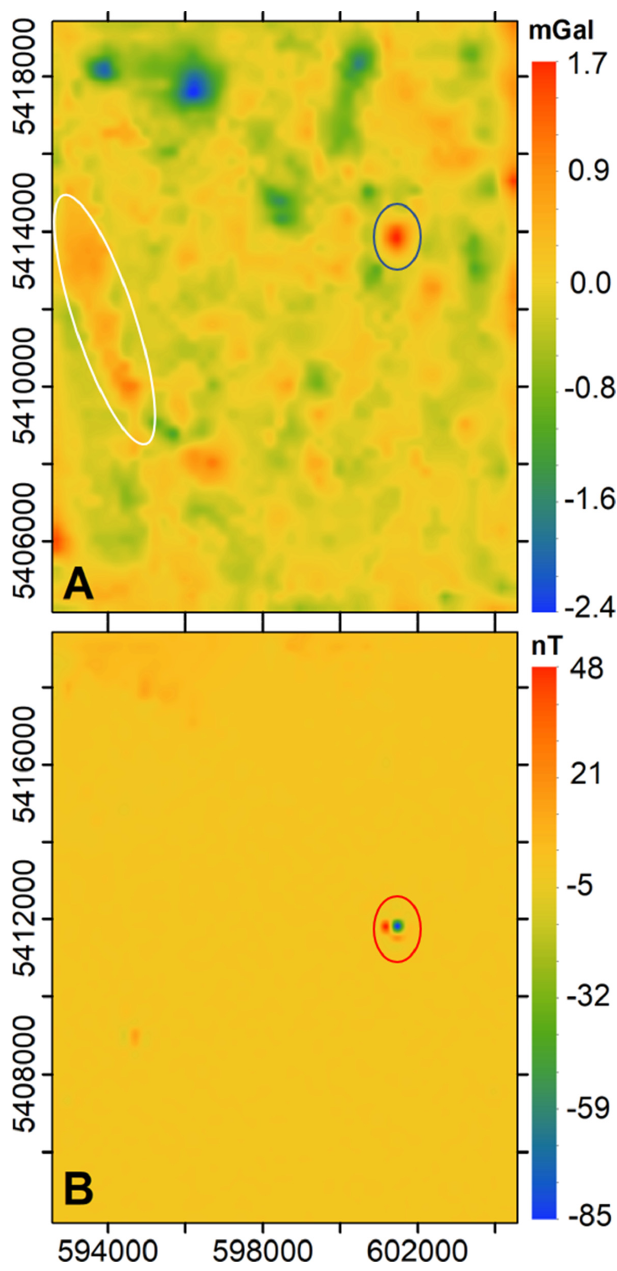
Figure 24. ( A ) The gravity residual misfit after cooperative inversion for the Scamander 3D model. The rms misfit stabilized at around 0.3 mGal, which is very low. Black and white ellipses highlight positive residuals associated with the Orieco copper prospect and Catos Creek dyke. ( B ) The TMI residual misfit with the rms misfit stabilizing at around 3 nT. The red ellipse represents outlier residuals associated with the North Scamander Cu, Pb-Zn-Ag prospect. The deposit is strongly magnetic, consisting of vein-hosted sulfide minerals with massive magnetite and pyrrhotite [68].